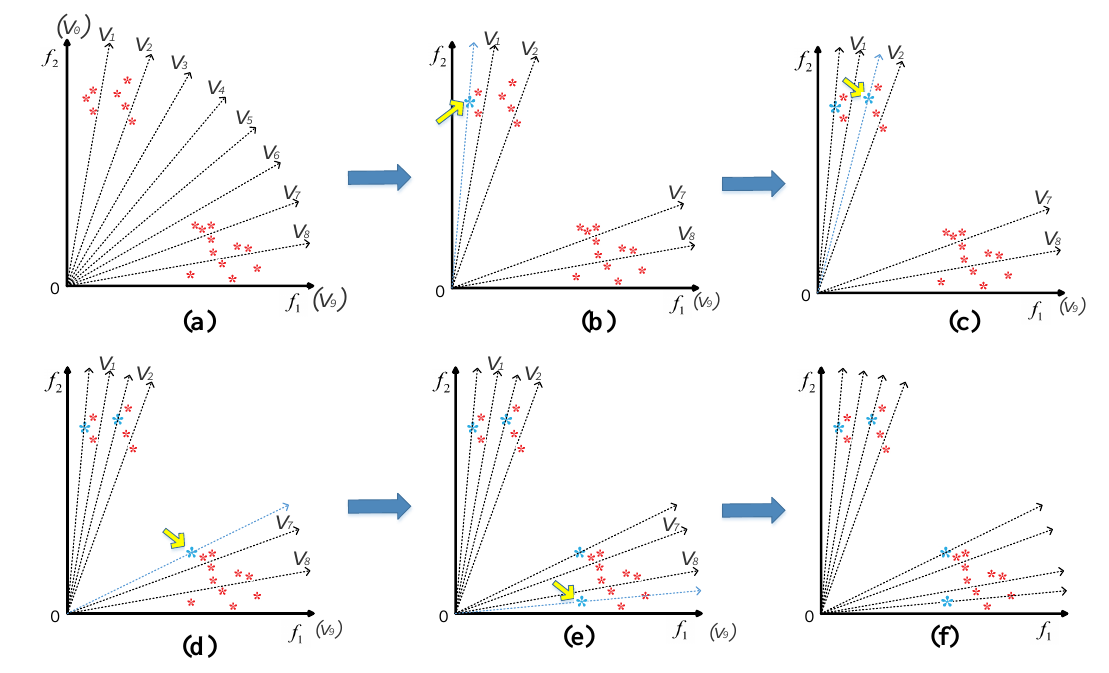
Figure 5. Example showing the steps of the strategy for the second state. ( a ) Predefined reference vectors and candidate solutions (the red asterisks). ( b – e ) Delete inactive solutions and construct new reference vector using the blue asterisks pointed by the yellow arrows. ( f ) The final set of reference